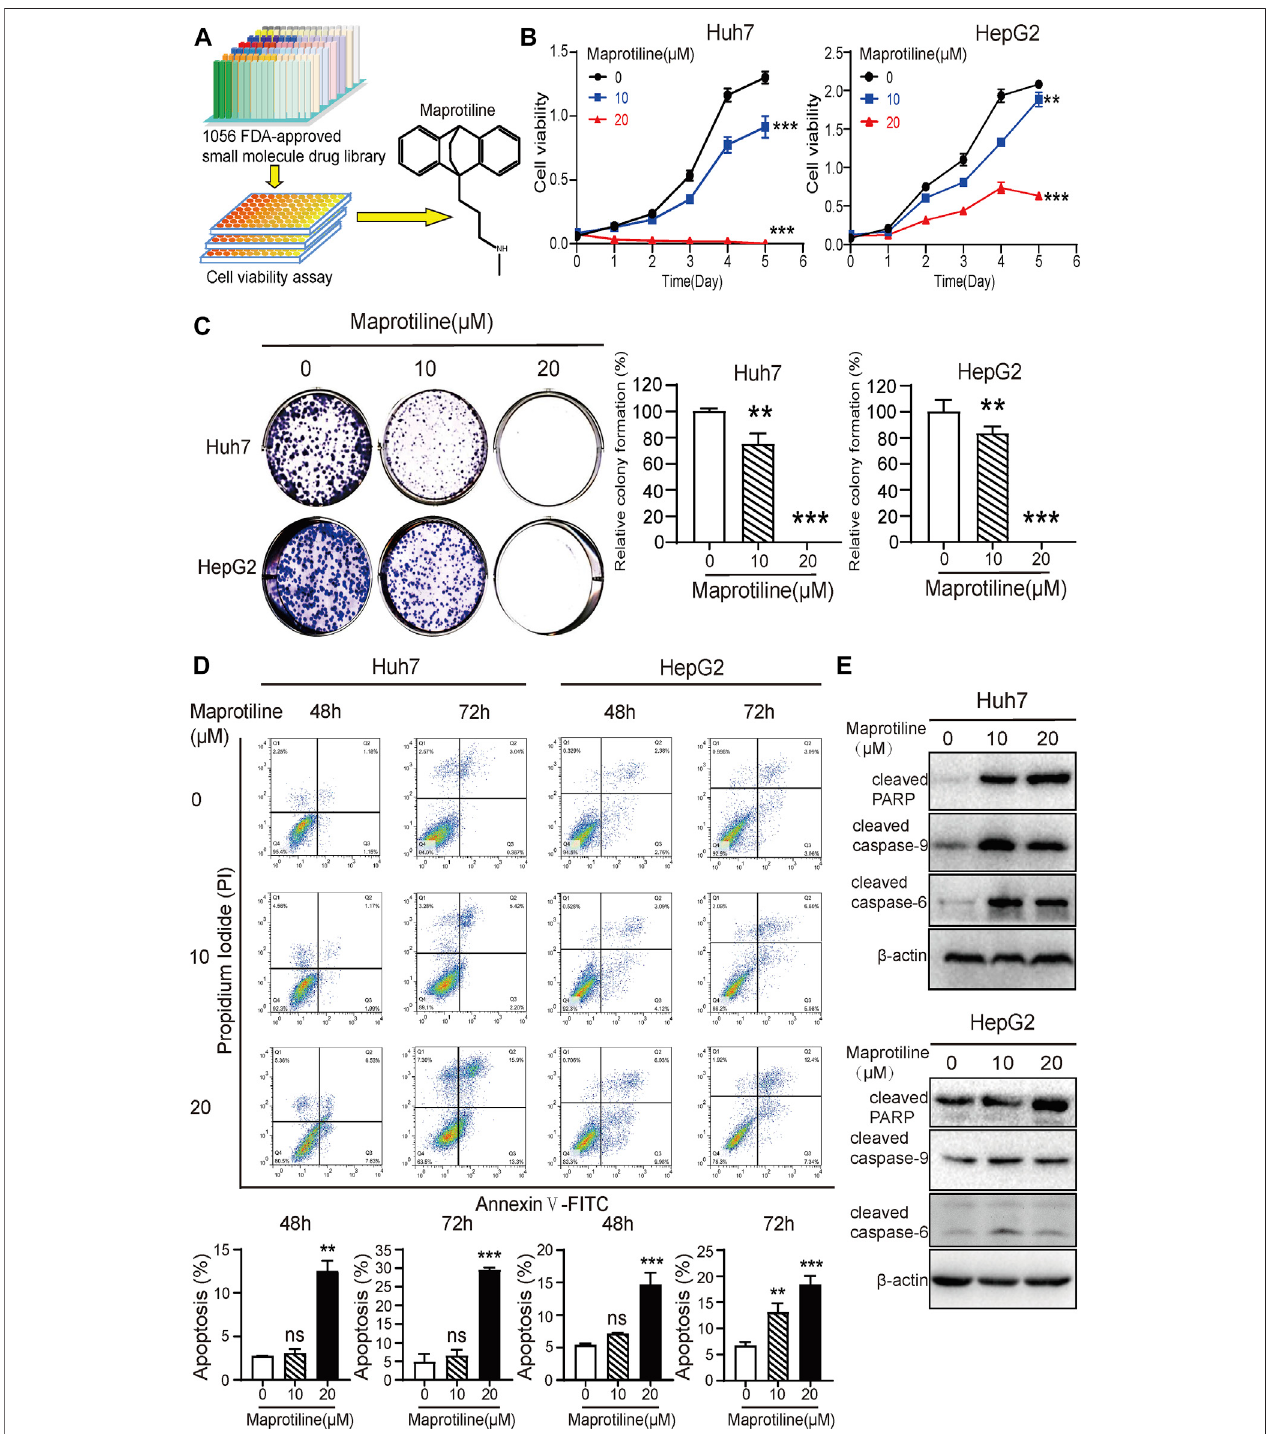
FIGURE 1 | Maprotiline inhibits growth and induces apoptosis in Huh7 and HepG2 HCC cells. (A) The drug screening procedure and the molecular structure of maprotiline. (B) Cell viability assays of Huh7 and HepG2 cells treated with 0, 10, or 20 μ M maprotiline for 0, 24, 48, 72, 96, or 120 h. (C) Maprotiline inhibited the colony formationability ofHuh7and HepG2 cells. (D) Thedetection ofapoptosis inHuh7 and HepG2cells treated withmaprotiline at concentrationsof0,10, and 20 μ M for48 and 72 h by an Annexin V-FITC/PI double staining assay. (E) Western blots of cleaved caspase-6, cleaved caspase-9 and cleaved caspase-PARP in Huh7 and HepG2 cells treated with 0, 10, or 20 μ M maprotiline for 72 h.